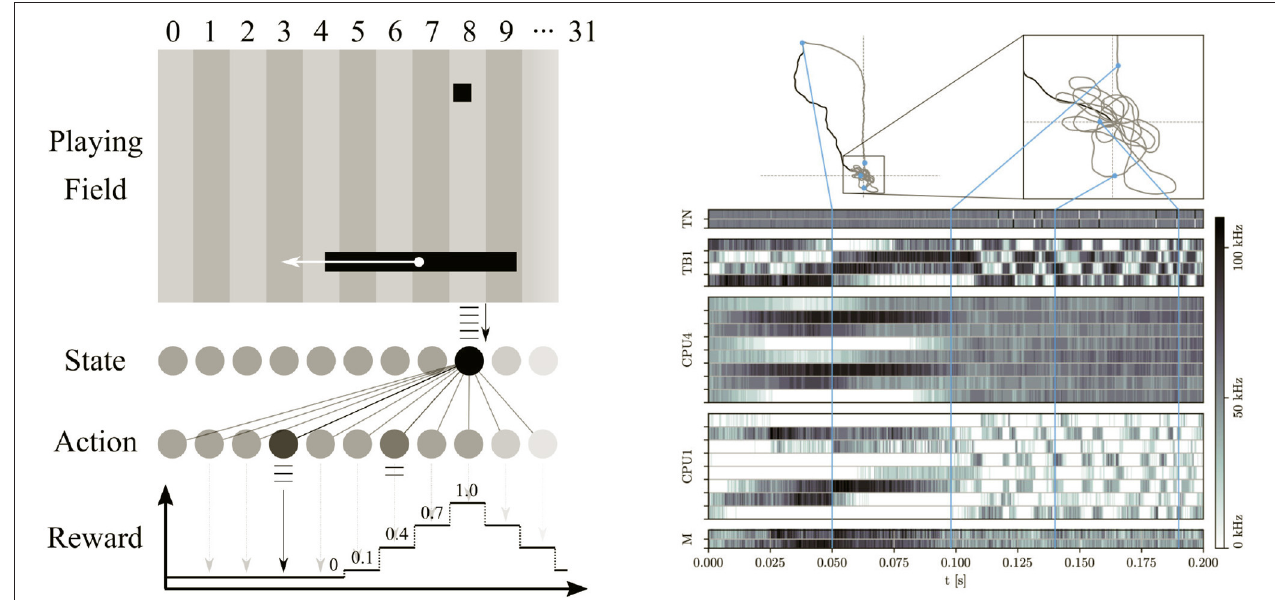
FIGURE 11 | (Left) Reinforcement learning: the chip implements a spiking neural network sensing the current ball position and controlling the game paddle. It is trained via a reward-based STDP learning rule to achieve almost optimal performance. The game environment, the motor command and stimulus handling, the reward calculation and the plasticity is performed by a C++ program running on the on-chip processor. Figure taken from Wunderlich et al. (2019). (Right) Recording of a virtual insect navigating a simulated environment. The top panels show the forced swarm-out path in black. During this phase, the SNN emulated by the analog neuron and synapse circuits on BSS-2 perform path integration. Afterwards, the insect flies freely and successfully finds its way back to the starting point and circles around it (gray trajectory). The bottom panel shows the neuronal activity during the experiment. The environment simulation as well as the interaction with the insect is performed by a C++ program running on the on-chip processor. Figure taken from Pehle et al.